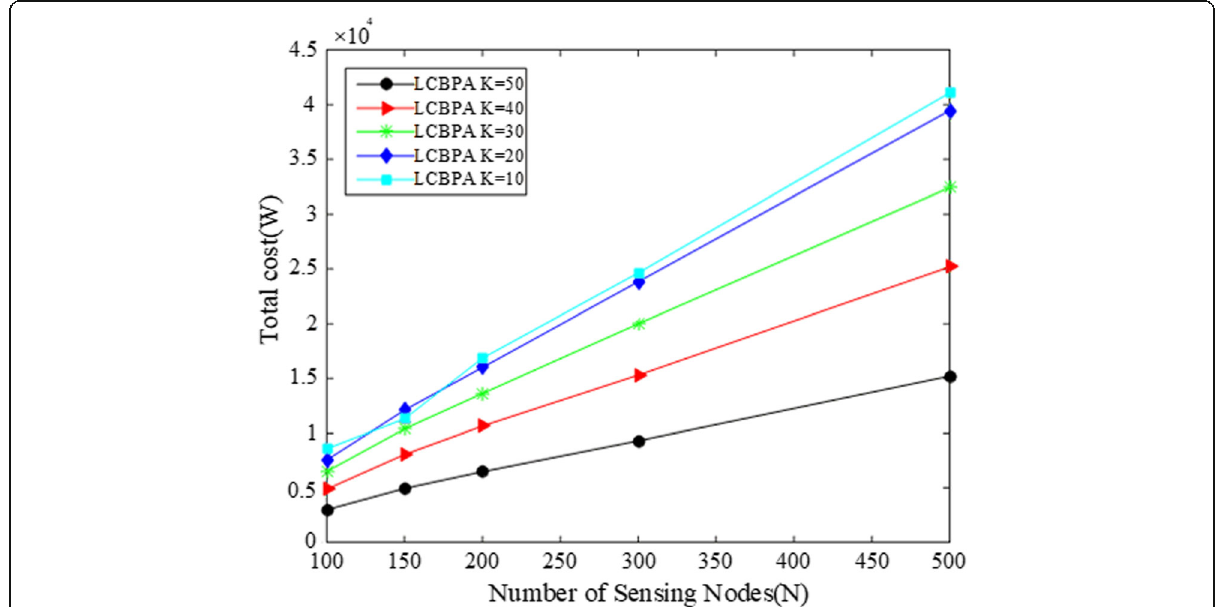
Fig. 6 Total cost comparison of LCBPA with different sub-task number k , when α = 0.5under different network